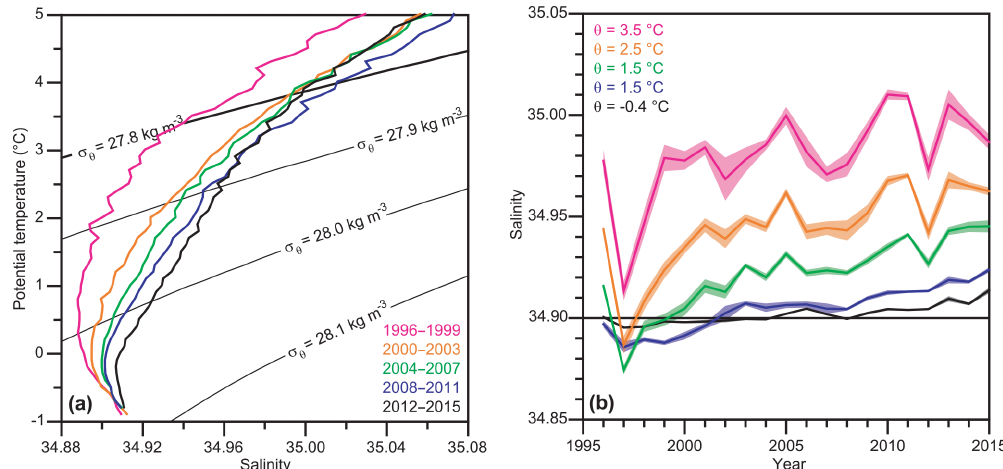
Figure 7. Temporal variations of the water mass characteristics in the deep parts of the FSC. (a) θ – S traces averaged over consecutive 4-year periods. (b) Salinity trends for five different potential temperatures where the annual averages are shown by the colored lines surrounded by shaded areas representing average ± 1 standard error for each year. The figure is based on 505 CTD profiles from area A in the FSC (Fig. 1).